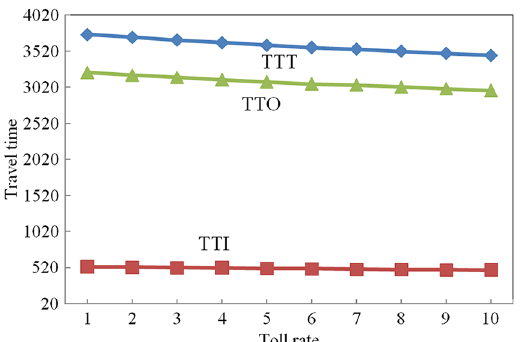
Fig. 2. Analysis of demand under cordon pricing